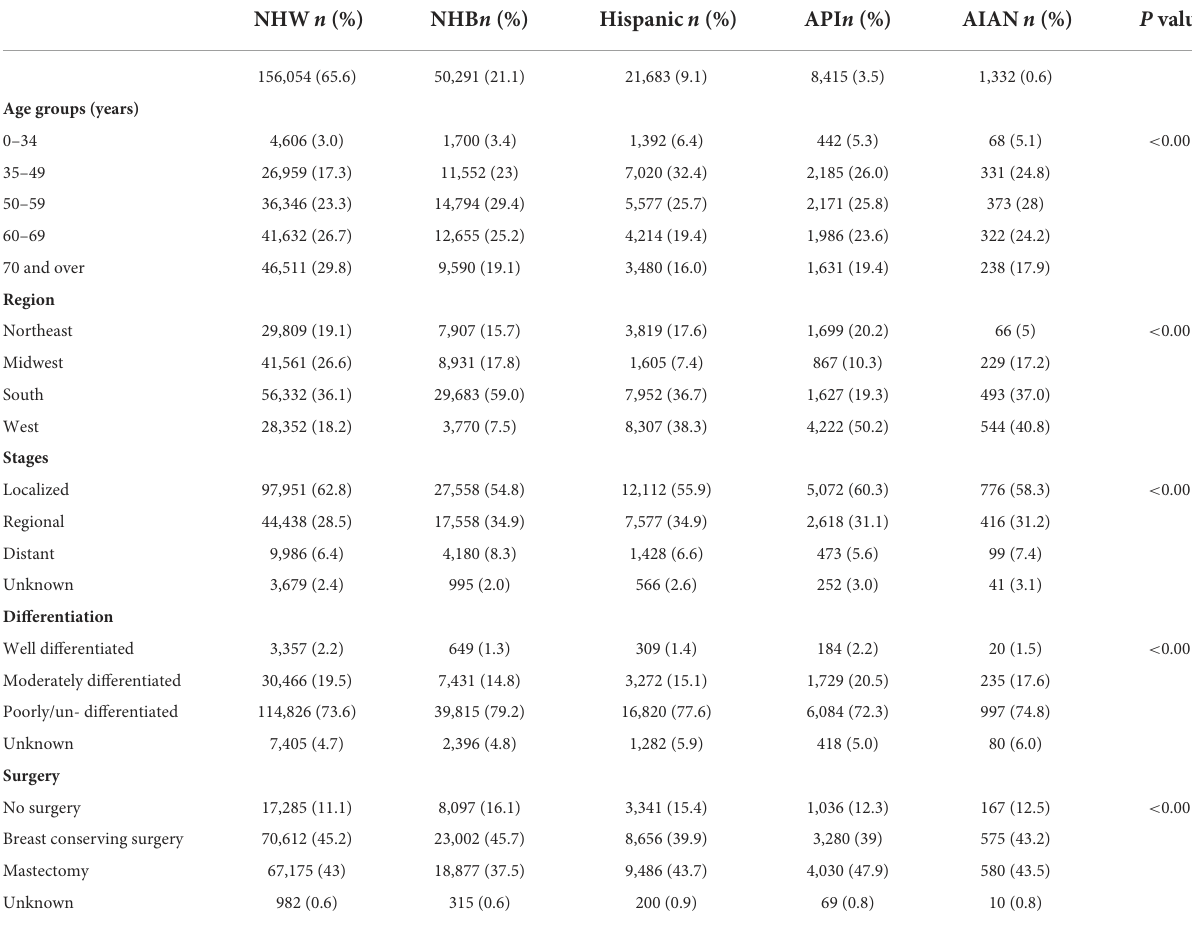
TABLE 2 Characteristics of newly diagnosed TNBC by races during